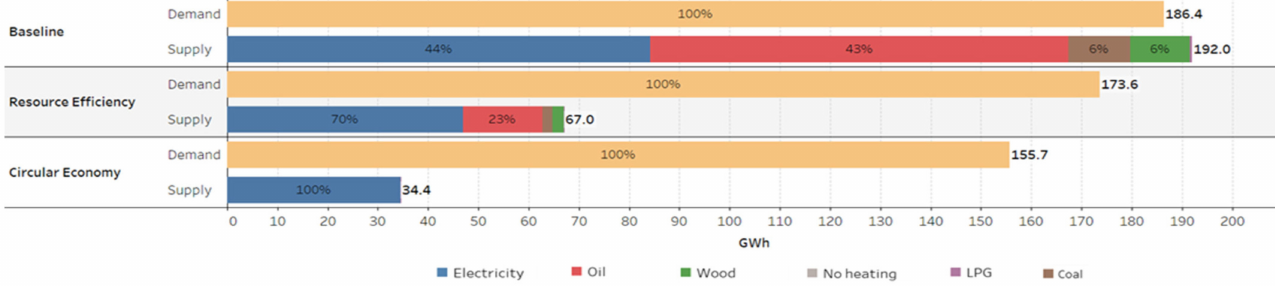
Figure 9. Comparison of energy demand and supply for house archetypes with heat pump uptake scenarios by fuel